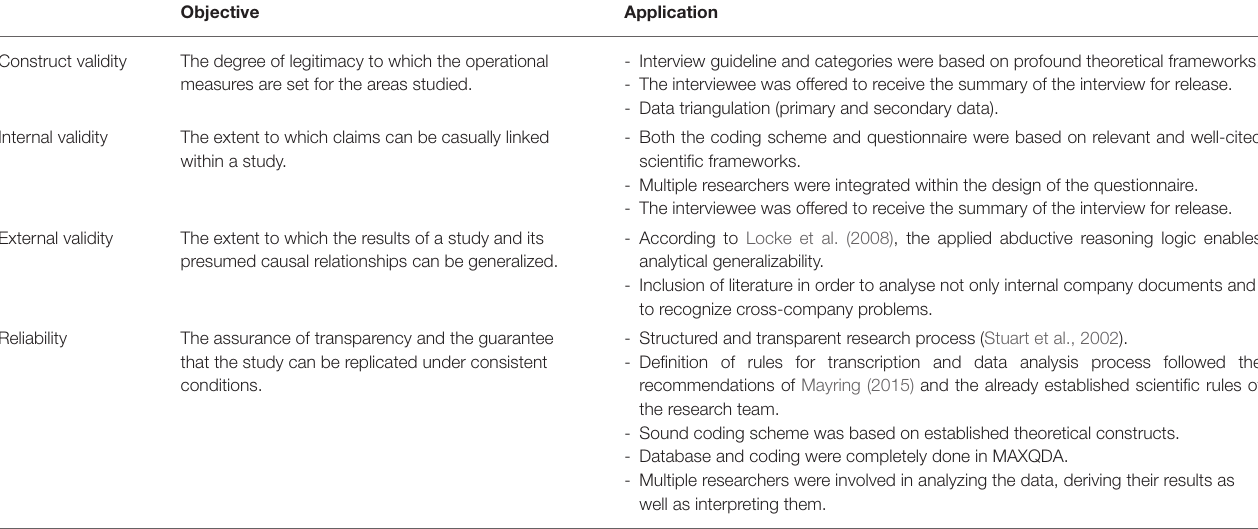
TABLE 2 | Research quality measures.